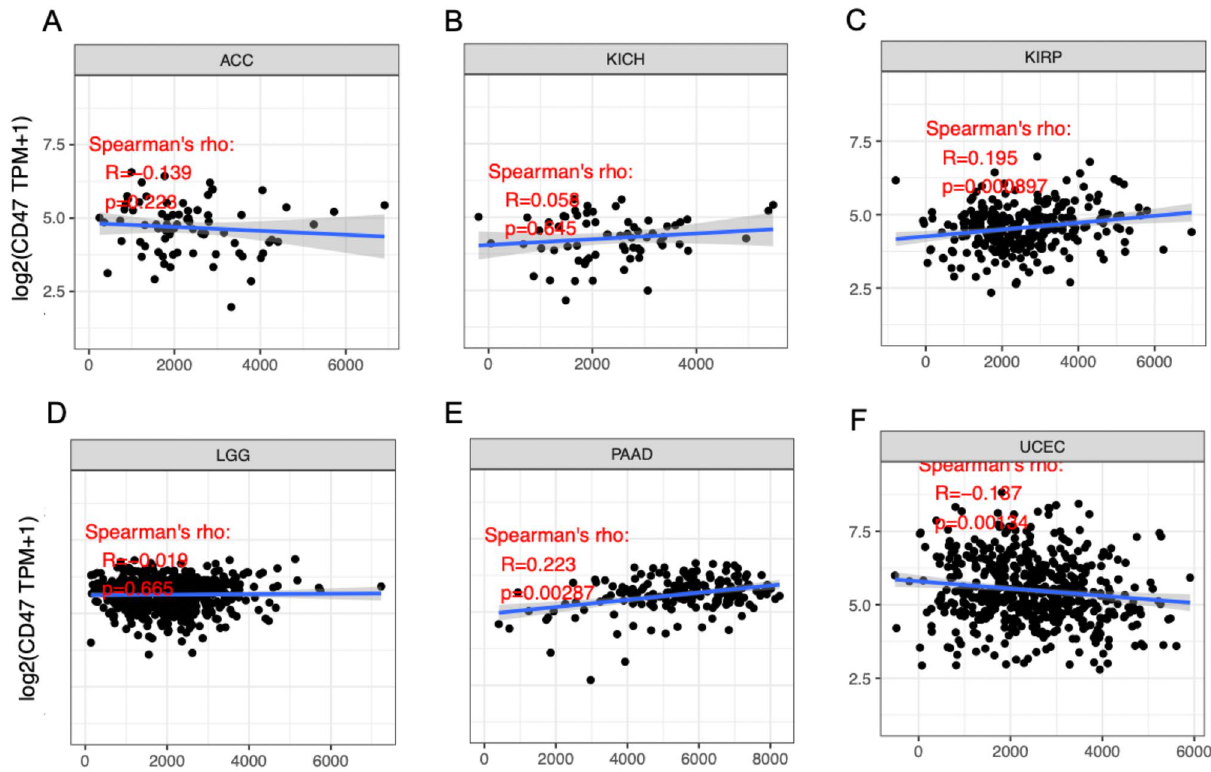
Figure 5. Correlation of CD47 expression with Stromal Score in ACC, KICH, KIRP, LGG, PAAD, UCEC ( A – F ). The level of CD47 expression was negatively associated with tumor purity in UCEC, and positively related to tumor purity in KIRP, PAAD and no significance in ACC, LGG, and